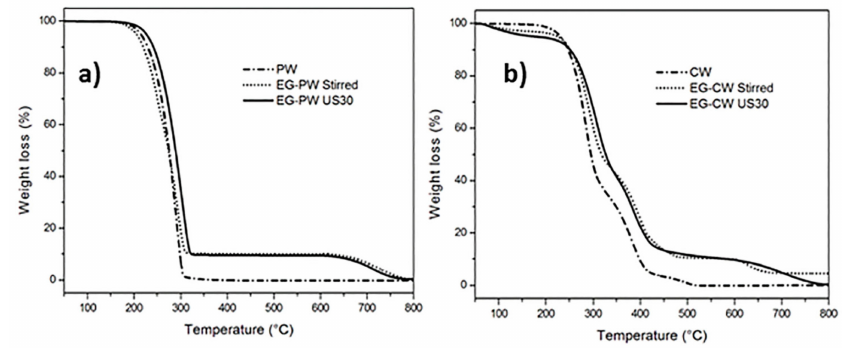
Figure 6. Thermogravimetric analysis (TGA) thermograms of PW–EG and CW–EG systems during heating at 10 ◦ C /